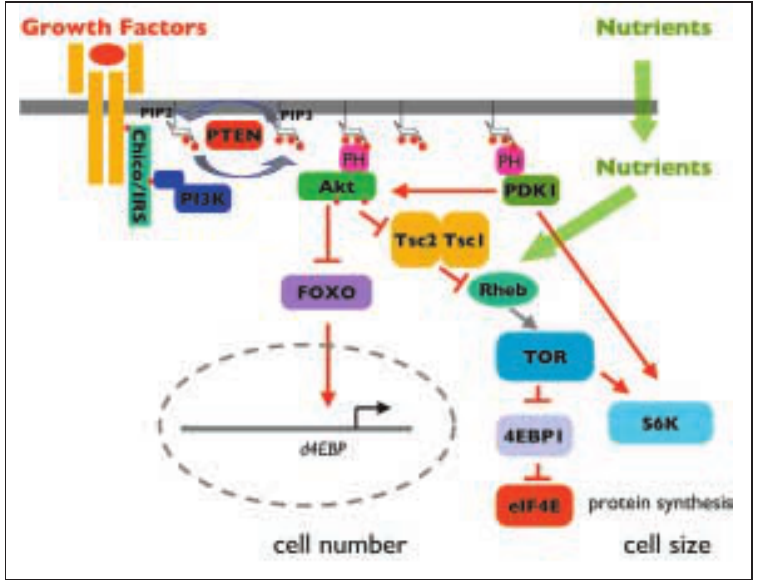
Diagram of the insulin/IGF signalling pathway. Indicated are the key elements of this pathway that have been identified and characterised genetically and biochemically. Connections indicated in red represent direct physical interactions. See text for